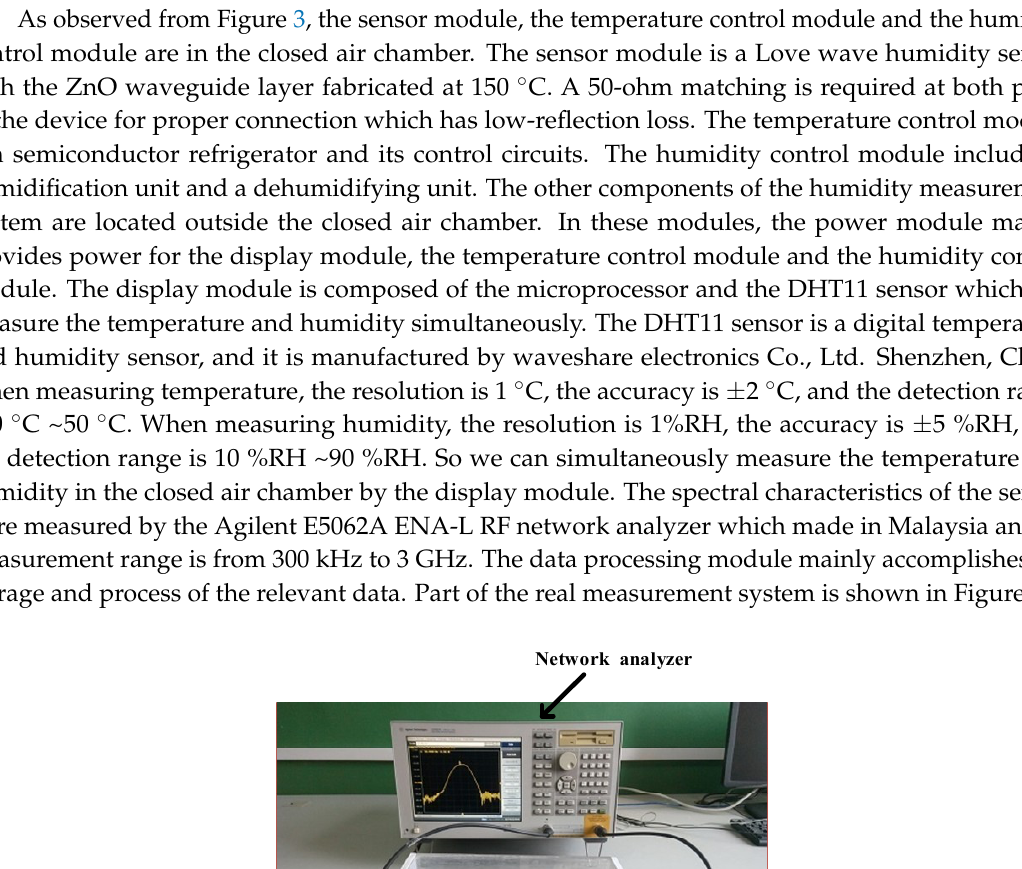
Figure 5. XRD spectra of the ZnO waveguide layer.